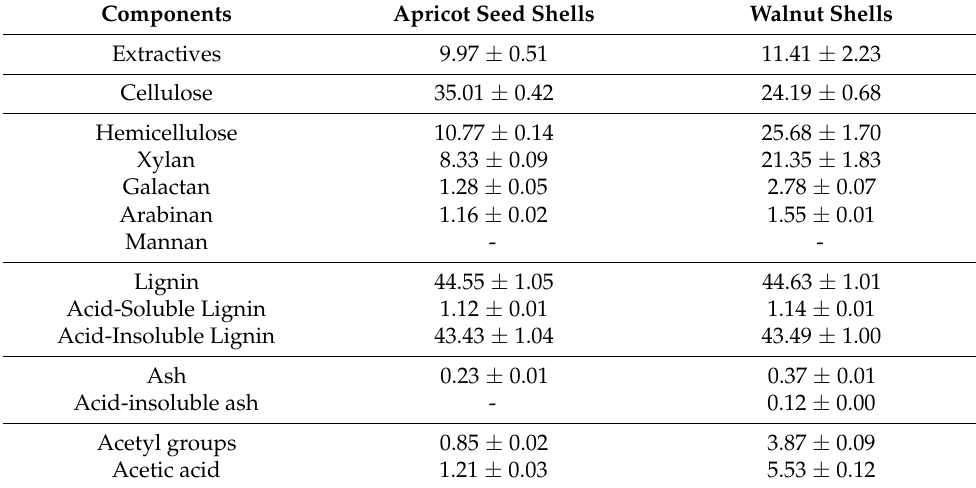
Table 1. Chemical composition of apricot seed shells and walnut shells (% dry